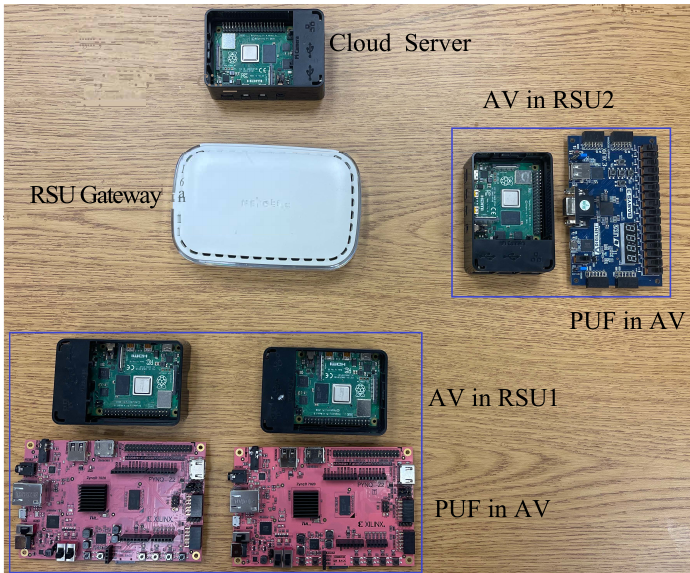
Figure 9. Experimental setup of the proposed protocol.